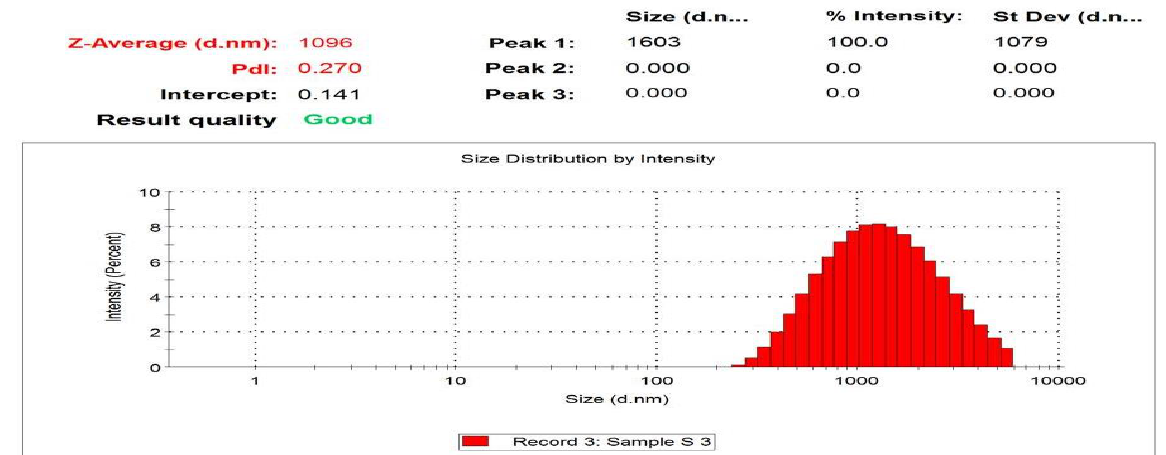
Figure 6: Particle size distribution by percentage